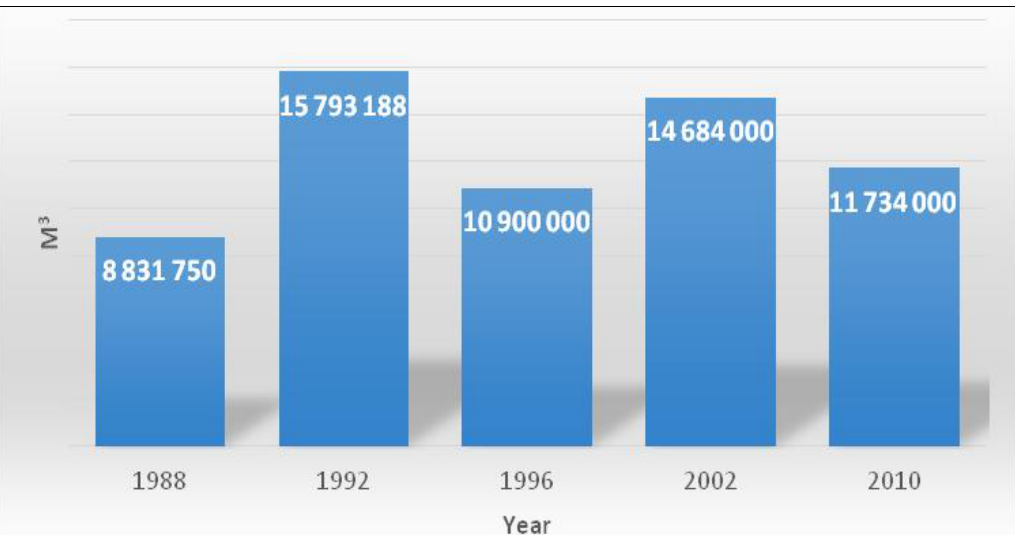
Fig. 2. Capital utilization of wood (m 3 ) in sawmills in Nigeria in the years 1988, 1992, 1996, 2002 and 2010 (after Ogunwusi,